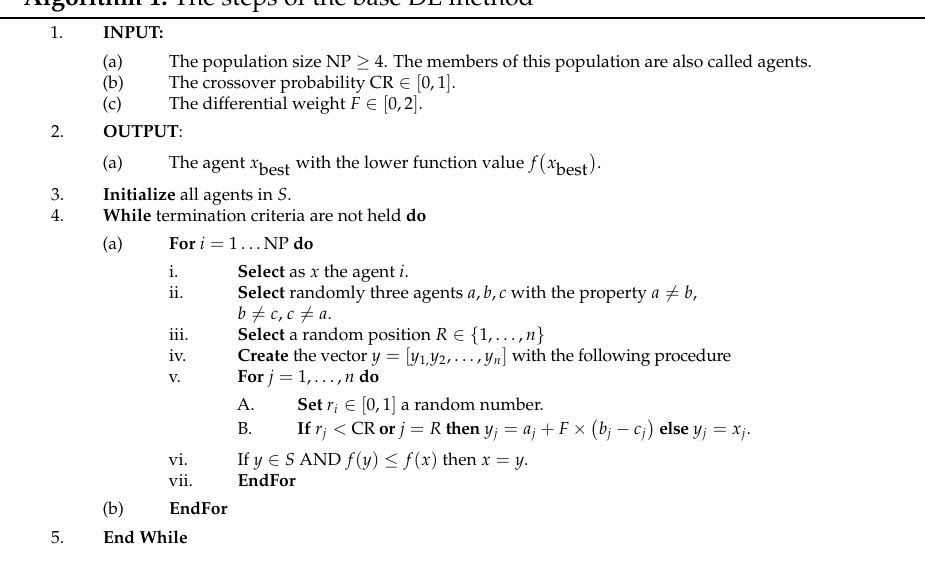
Algorithm 1: The steps of the base DE